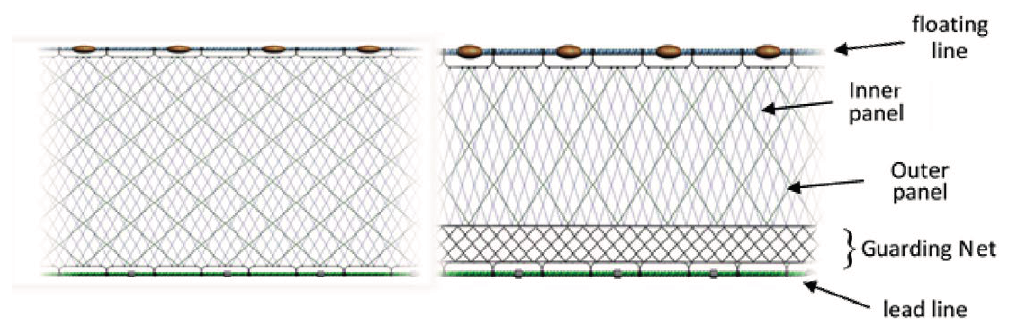
Fig. 2. – Scheme of a standard trammel net (left) and of a trammel net provided with a guarding net